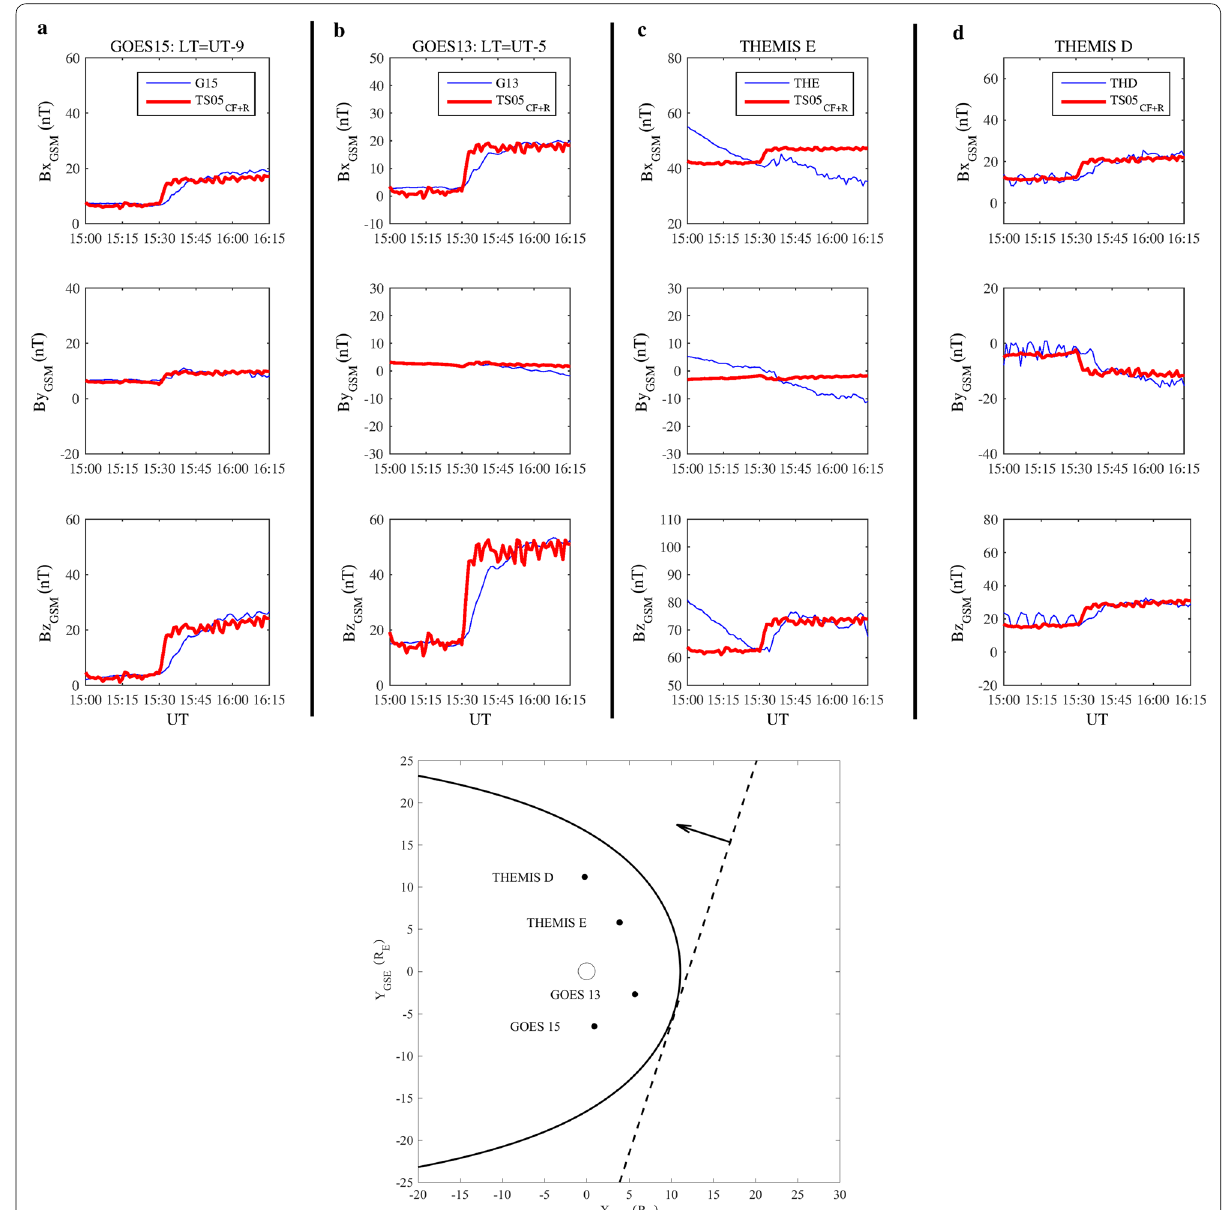
Fig. 5 Comparison between B x GSM (upper panels; GSM stands for the geocentric solar magnetic system), B y GSM (middle panels) and B z GSM (lower panels) observations (blue lines) and the B CF field output by the TS05 model (red lines; the subscript CF R means that the TS05 model has been + + R run by considering only the magnetopause and ring current contributions), for GOES15 (column a ), GOES13 (column b ), THEMIS E (column c ) and THEMIS D (column d ) on 27 May 2017 between 15:00 and 16:15 UT. The bottom panel shows the position of GOES13, GOES15, THEMIS D and THEMIS E (black full circles), the model-calculated magnetopause location before the IS passage (black thick line) and the direction of the IS front (black dashed lines) impinging the magnetopause. Black empty circle represents the Earth’s